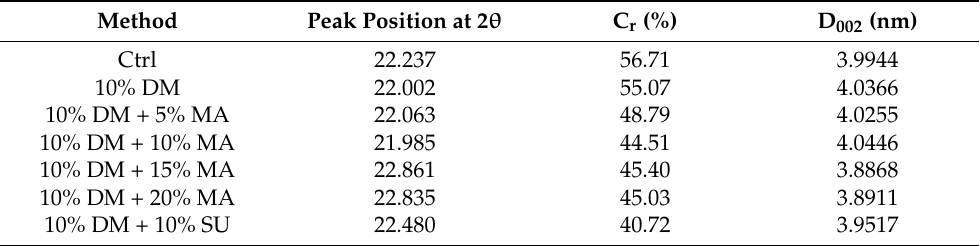
Figure 9. Effects of different modifiers on the X-ray diffraction patterns of poplar wood ( a ); Effects of MA concentrations on X-ray diffraction patterns of Poplar ( b ). Table 5. Crystalline characteristics of modified poplar wood with different chemical